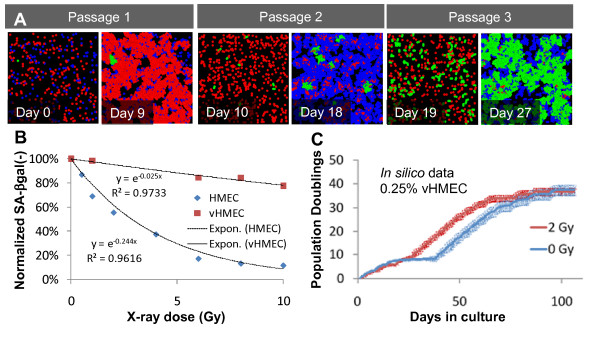
Differential sensitivity to radiation-induced senescence and loss of growth leads to increased outgrowth of p16(-) human mammary epithelial cells during stasis. (A) Time snapshots of one representative simulation of sequential subcultures executed using the same initial conditions as in Figure 6A, but including prematurely senescent human mammary epithelial cells (HMEC) agents (labeled blue) induced by exposure to 2 Gy of X-rays. Note the earlier and more robust outgrowth of vHMEC agents (labeled green) in this simulation versus the simulation shown in Figure 6A. (B) Growing pre- and post-stasis HMEC from the same individual were exposed to the indicated doses of X-rays, then stained and evaluated for SA-βgal expression. The resulting data were then normalized to the percentage of SA-βgal(-) HMEC in the respective unirradiated populations. Fitted curves were of the form (e(-α.D)) where D is the dose and α the fitted coefficient; R2 values were >0.96 in both cases. These fitted curves were used to model radiation-induced senescence in the simulation depicted in (A). (C) Agent-based modeling was used to simulate the growth kinetics of HMEC cultures exposed to 0 or 2 Gy of X-rays. Data ± SE for five independent simulations for each condition are plotted. Note that the model predicts a shorter growth plateau in the irradiated sample, in accord with experimental observations.